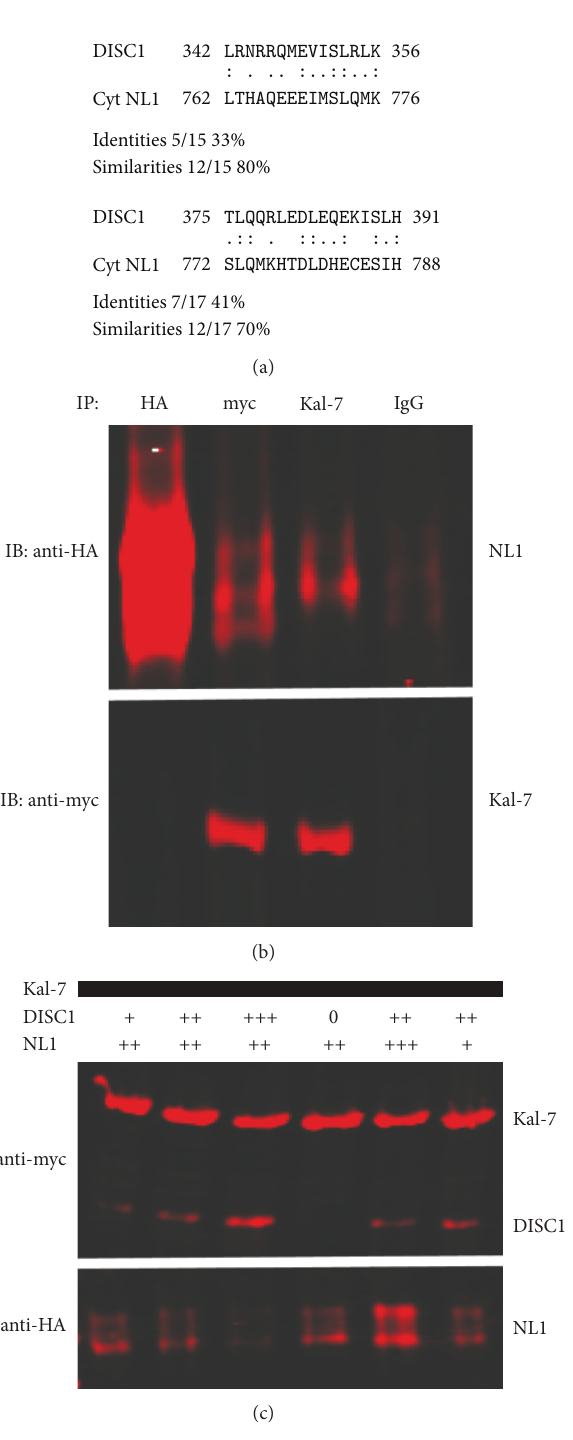
Figure 2: Neuroligin 1 interacts with kalirin 7. (a) 293T cells were transfected with HA-tagged NL1-AB or myc-tagged Kal-7. Cell lysates were mixed and subsequently immunoprecipitated with anti- HA, anti-myc, or anti-Kal antibody, and immunoblots were probed with the indicated antibodies. Mouse IgG was used as a control. (b) HEK293 cells were transfected with HA-tagged NL1-AB or myc- taggedKal-7orFLAG-taggedDISC1.Celllysatesweremixedasindi- cated and subsequently immunoprecipitated. Immunoblots were probed with the indicated antibodies. Representative immunoblots of 𝑛 = 3 experiments are shown.